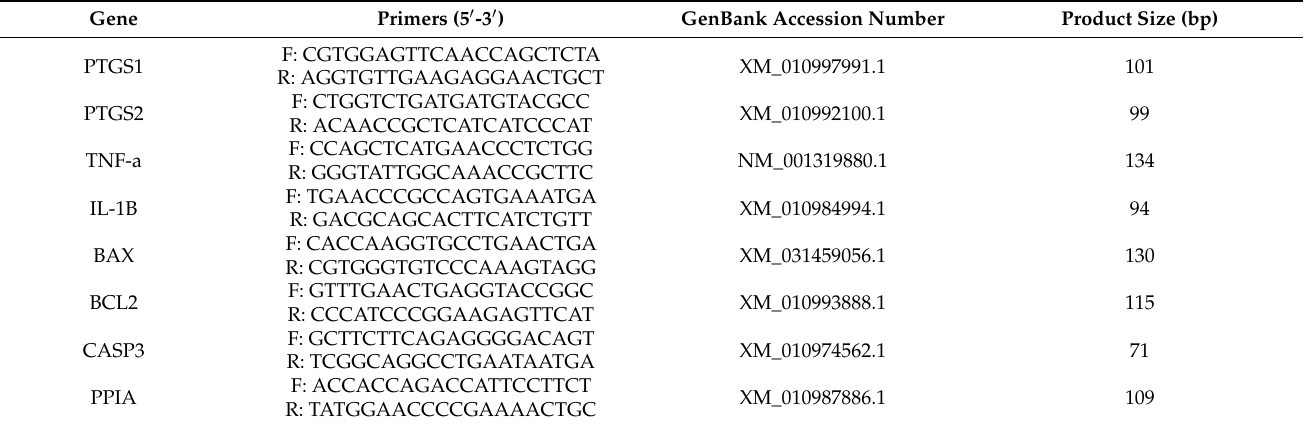
Table 1. Primers used for qRT-PCR.